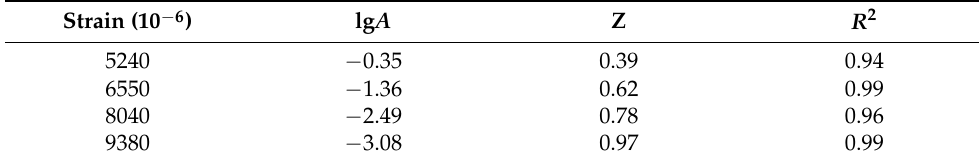
Table 7. Fitting Results of Parameters.